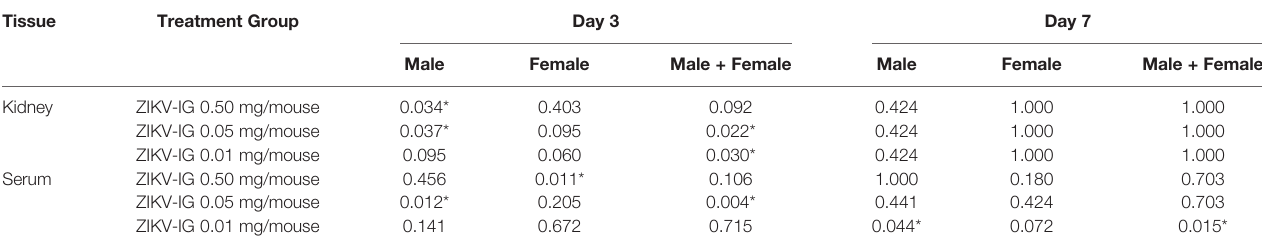
TABLE 4 | Analysis of viral load in male and female mice on days 3 and 7.